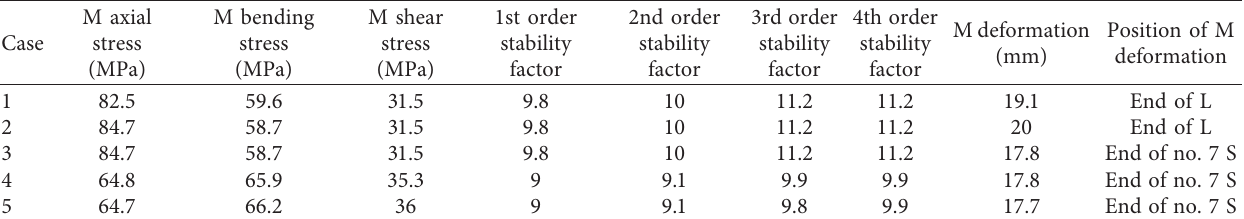
Figure 3: Force transmission rules of the inverted triangle form traveller. HC (i), WP (i), and TB (i) denote the spreader beams in the horseshoe chamfer area, web plate area, and top and bottom plate area in the no. i case ((i) � 1–5), respectively. Cases 1 to 5 denote the cantilever box-girder segment loading of no. 2, no. 4, no.13, no.15, and no.17 with the dip angles of 31.94, 27.83, 9.88, 6.17, and 2.52 degrees, respectively. (a) 3D view of the form traveler. (b) Profile (unit: mm). (c) Plane (unit: mm). (d) Numbering of the spread beams (unit: mm). (e) Typical cross-section (unit: cm). (f) Numbering of the segments (unit: cm). (g) Force distribution on the spread beams. (h) Constraint release of the FE model. Table 2: Stress, stability, and deformation of the form traveler in typical cantilever loading cases. M denotes maximum and L and S denote the longitudinal beam and spread beam, respectively. Five cases are illustrated in Figure